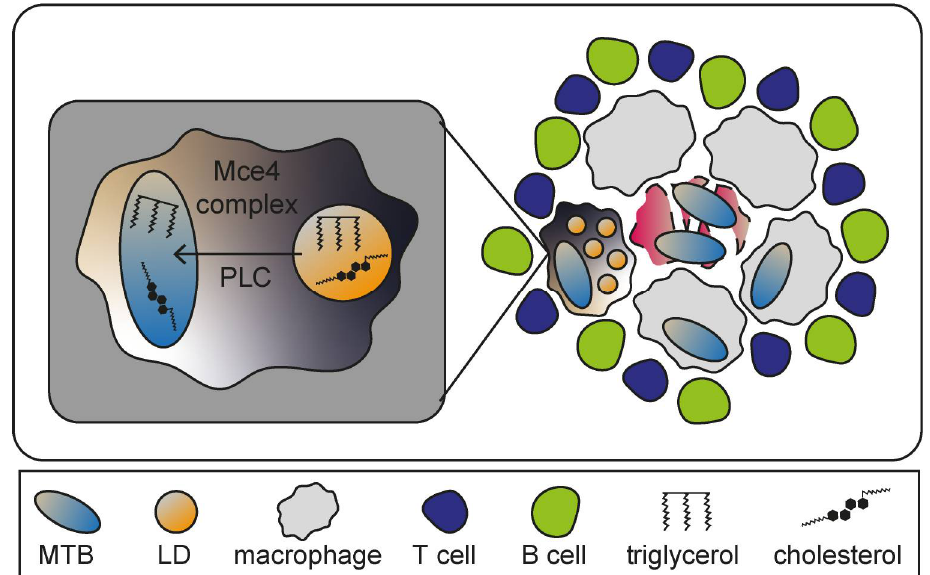
Figure 7. Granuloma formation induced by Mycobacterium tuberculosis (MTB). After phagocytosis, MTB mediates the recruitment of diverse macrophages that serve as protection against lymphocytes such as B cells and T cells. This accumulations of immune cells as consequence of MTB infection are termed granuloma. Foamy macrophages have a specialized morphology due to high amounts of lipid droplets (LDs). MTB exploits these LDs for nutritional supply with the help of lipid import systems such as Mce4 complex and phospholipase C (PLC). Severe tissue damage can be observed as result of MTB-induced necrosis of